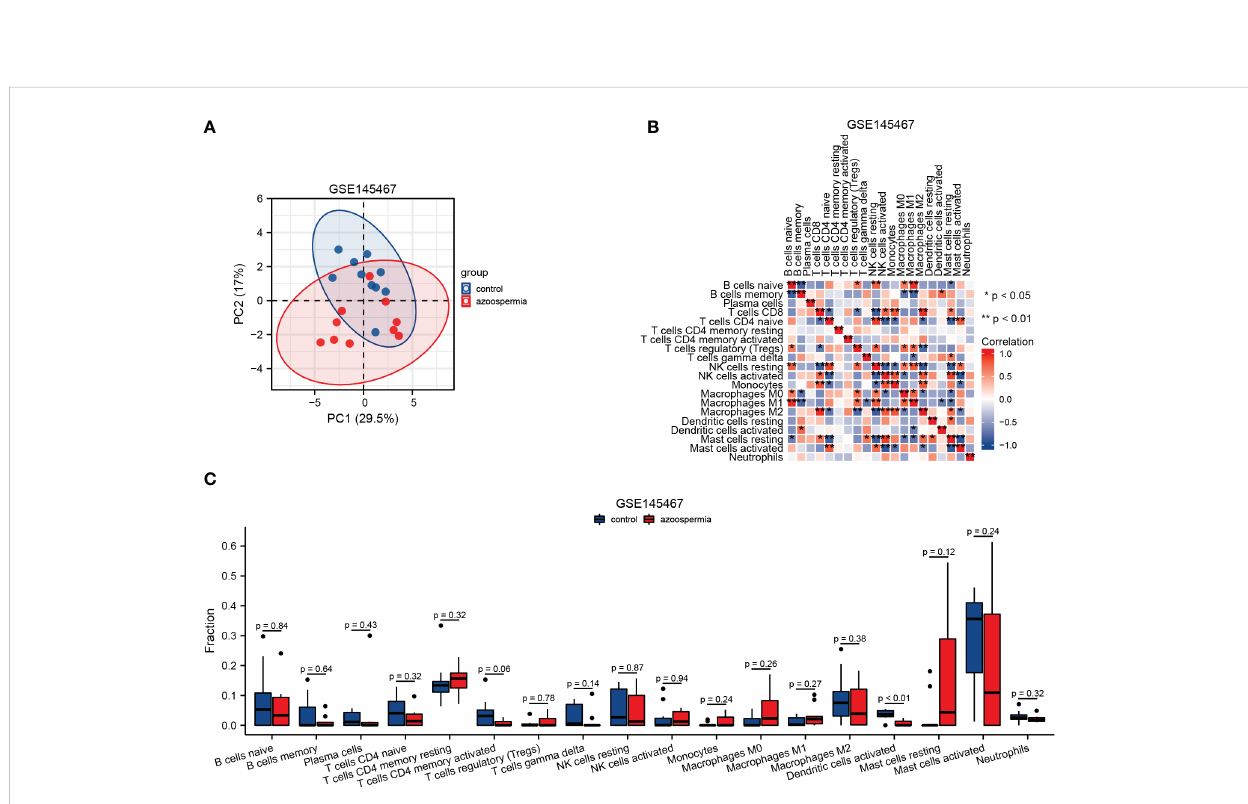
FIGURE 7 In fi ltration of immune cells in GSE145467. (A) : Principal component analysis diagram of immune cell in fi ltration of samples from the normal spermatogenesis and impaired spermatogenesis groups. (B) : Immune correlation matrix. (C) : Differences in immune cells between the normal spermatogenesis and impaired spermatogenesis